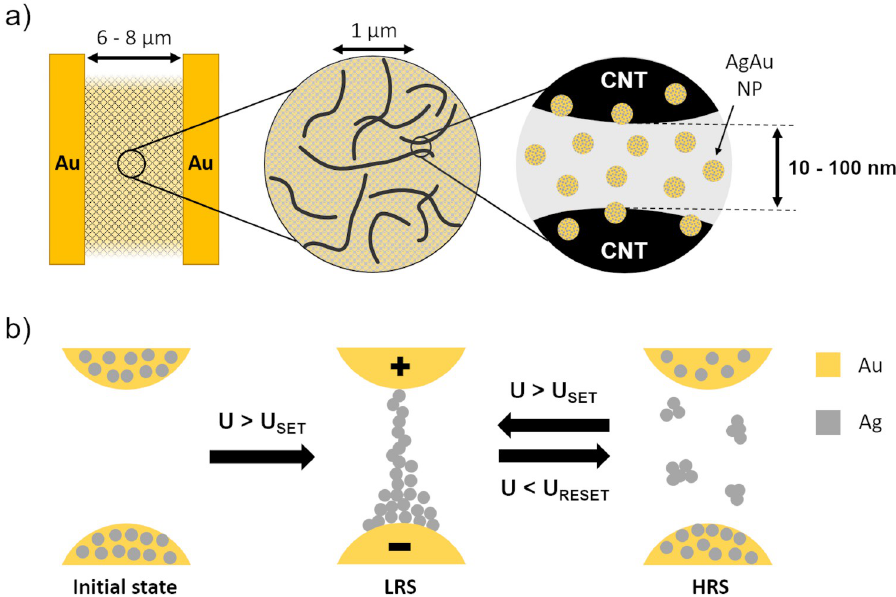
Fig 1. Schematic illustration of the key features and switching mechanism of the CNT/AgAu. a) Vital components of a CNT/AgAu network from left to right: The inert electrodes, the sparse CNT network and the AgAu nanoparticles inside a nanogap between two individual CNTs. b) The switching mechanism between two NPs when exposed to a potential U. LRS = Low resistive state, HRS = High resistive state.